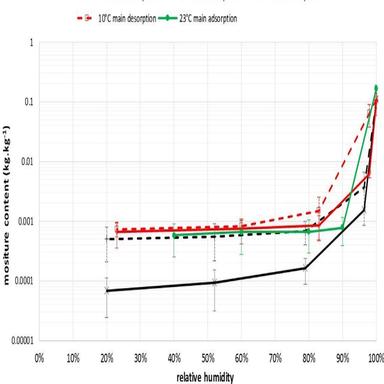
Experimental main adsorption and desorption isotherms at 10 C, 23 C and 40 C.